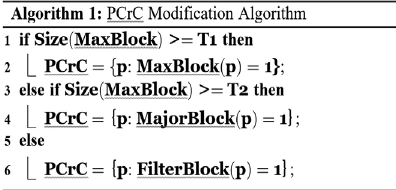
Figure 9. PCrC modification